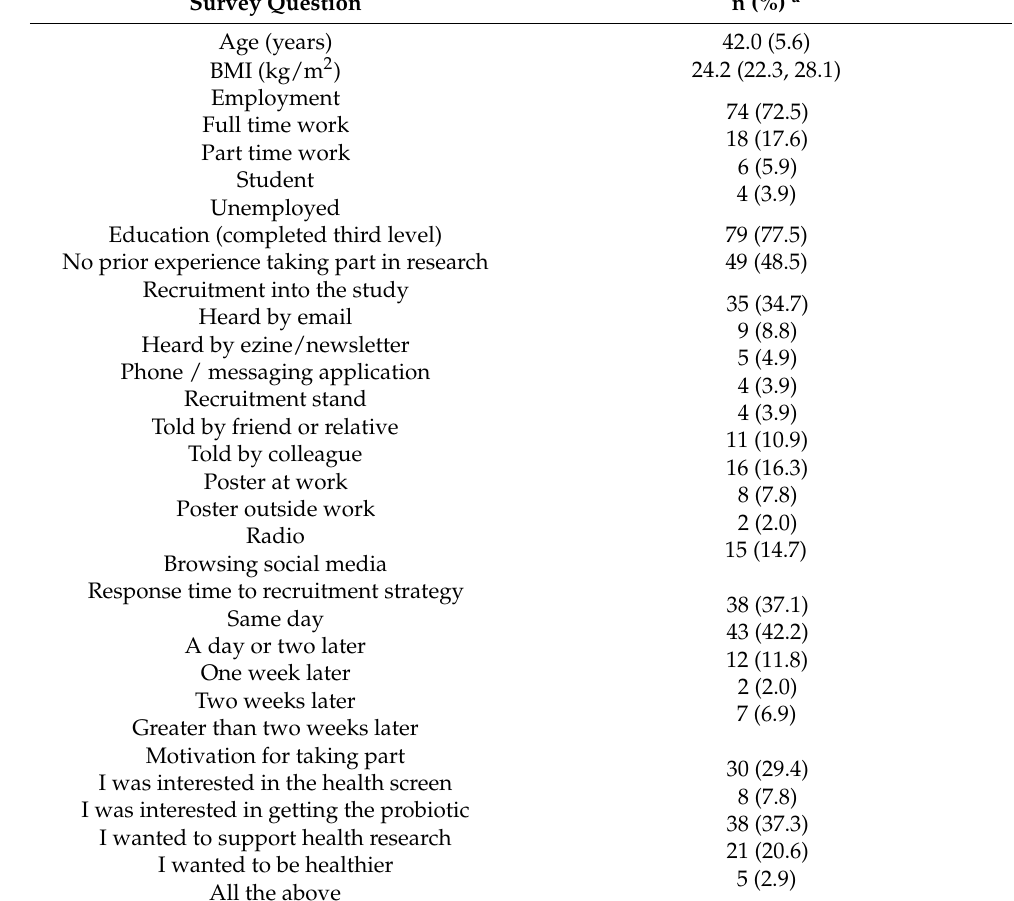
Table 1. Characteristics of survey respondents (n = 102).